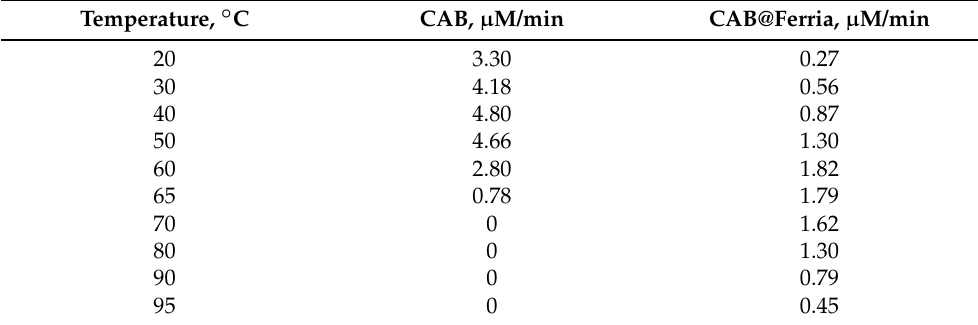
Table 1. pNPA conversion rate as a function of temperature for CAB and CAB@Ferria.